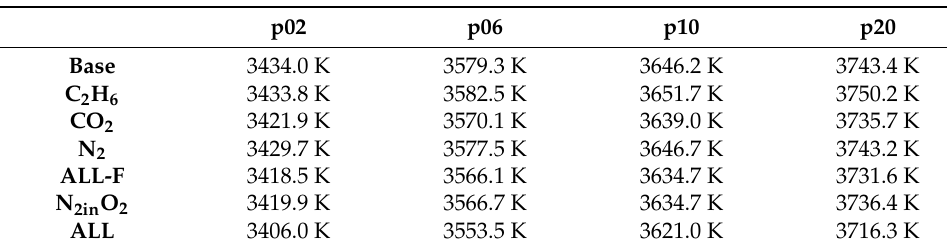
Figure 6. Numerical mesh for the CFD simulation: ( a ) inlet and ( b ) nozzle. Table 10. Maximum combustion temperature for different pollutants of the fuel and/or the oxidizer at different pressure levels (CFD simulation).